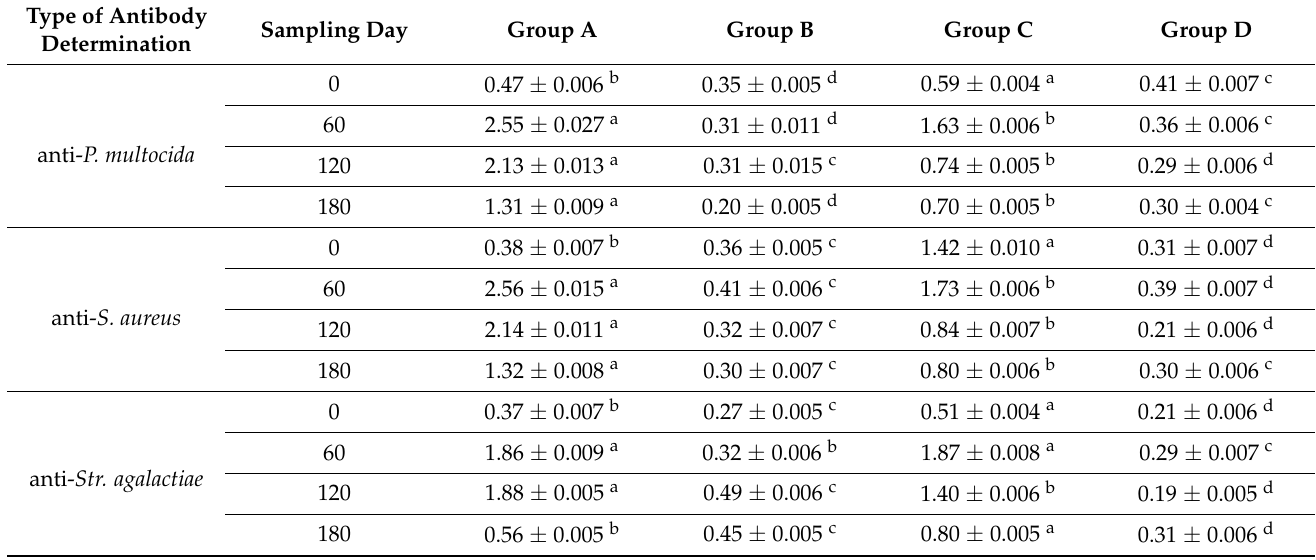
Table 2. Serum antibody titers produced by HS–mastitis combined